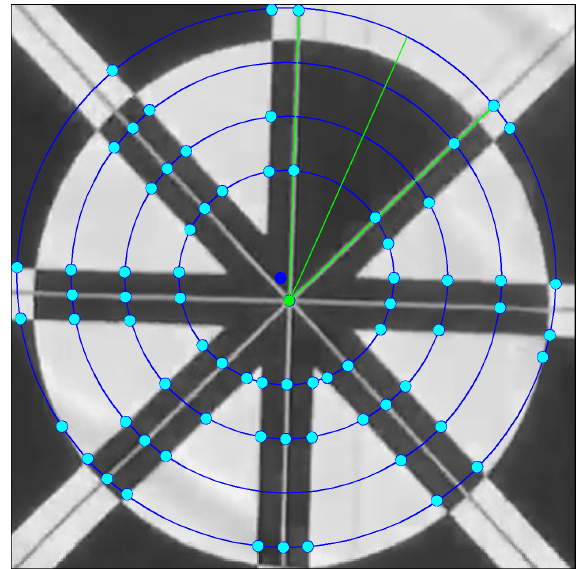
Figure 7. Strategy to predict marker center when the drone is close to the marker. Using the detected center (dark blue point) obtained by the ATM algorithm as the input for the Kalman Filter in the case where the profile checker algorithm fails, we obtained the corrected one (green point) as the final prediction. The direction of the marker is again estimated using the profile checker algorithm with the final center.